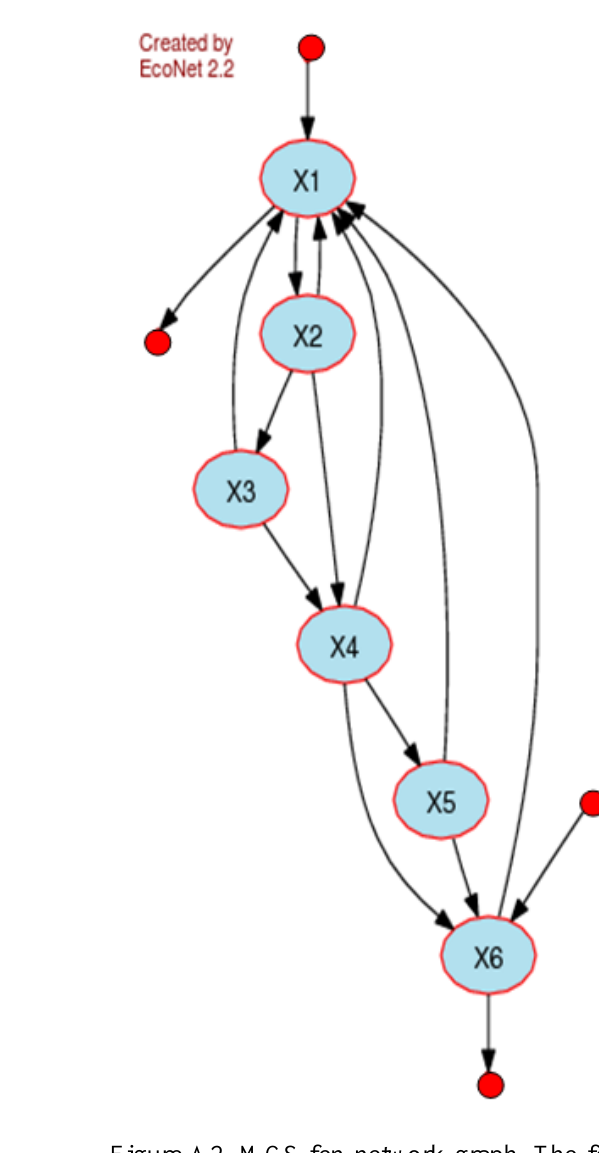
Figure A2. MCS fen network graph. The four red dots indicate external carbon flows in the mire